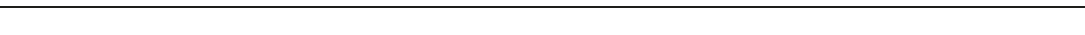
Fig. 7 Upstream transcription factor 1 (USF1) transcriptionally regulates expression of INSM2 and uc.372. a Identi fi cation of usf1 elevated in the liver of 8- week-old male db/db mice ( n = 5). b Identi fi cation of usf1 elevated in the liver of 10-week-HFD-fed mice ( n = 5). c Expression of USF1 in the HepG2 cells treated with 300 μ M O/P mixture for 48 h ( n = 3). d Expression levels of USF1 , uc.372, INSM2 , and Nox2 in the HepG2 cells infected with Ad-USF1 or Ad- NC for 48 h ( n = 3). e Protein levels of ACC, FAS, SCD1, and CD36 in the HepG2 cells infected with Ad-USF1 or Ad-NC for 48 h (representative blots from three similar experiments) ( n = 3). f Real-time PCR analysis of USF1 , uc.372, INSM2 , and Nox2 in the HepG2 cells transfected with speci fi c siRNAs targeting USF1 or NC for 48 h ( n = 3). g Western blot analysis of ACC, FAS, SCD1, and CD36 expression in the HepG2 cells transfected with speci fi c siRNAs targeting USF1 (representative blots from three similar experiments) ( n = 3). h The mRNA level of uc.372 in the HepG2 cells infected with Ad-USF1 in the presence or absence of siINSM2 or NC for 48 h ( n = 3). i The mRNA levels of USF1 and uc.372 in the HepG2 cells infected with Ad-USF1 and Ad-uc.372i for 48 h ( n = 3). j The mRNA levels of ACC , FAS , SCD1 , and CD36 in the HepG2 cells infected with Ad-USF1 and Ad-uc.372i or Ad-NC for 48 h ( n = 3). Data are mean